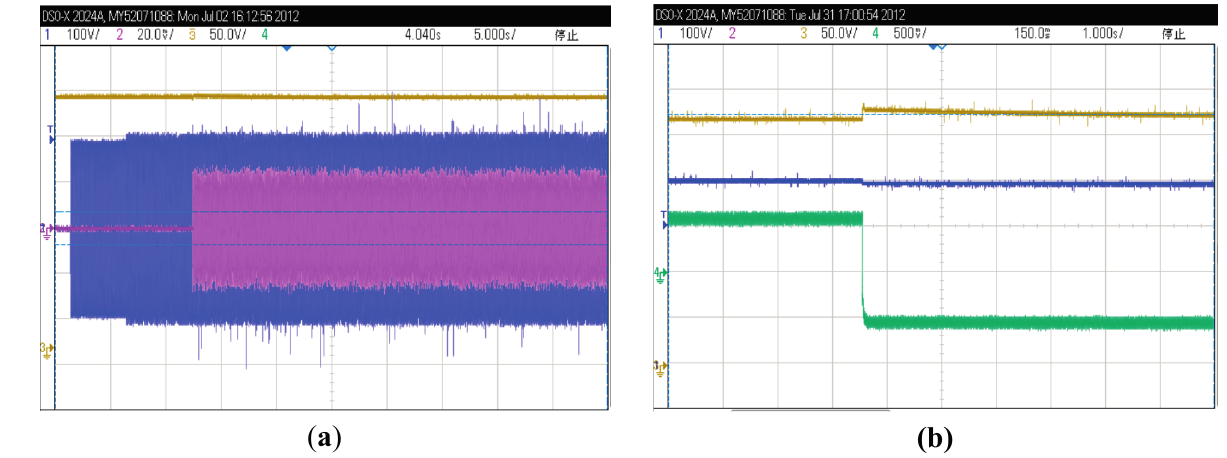
Figure 8. ( a ) Waveform of the AC-DC converter switching from islanded mode to grid-connected mode; ( b ) Waveform of the battery charging